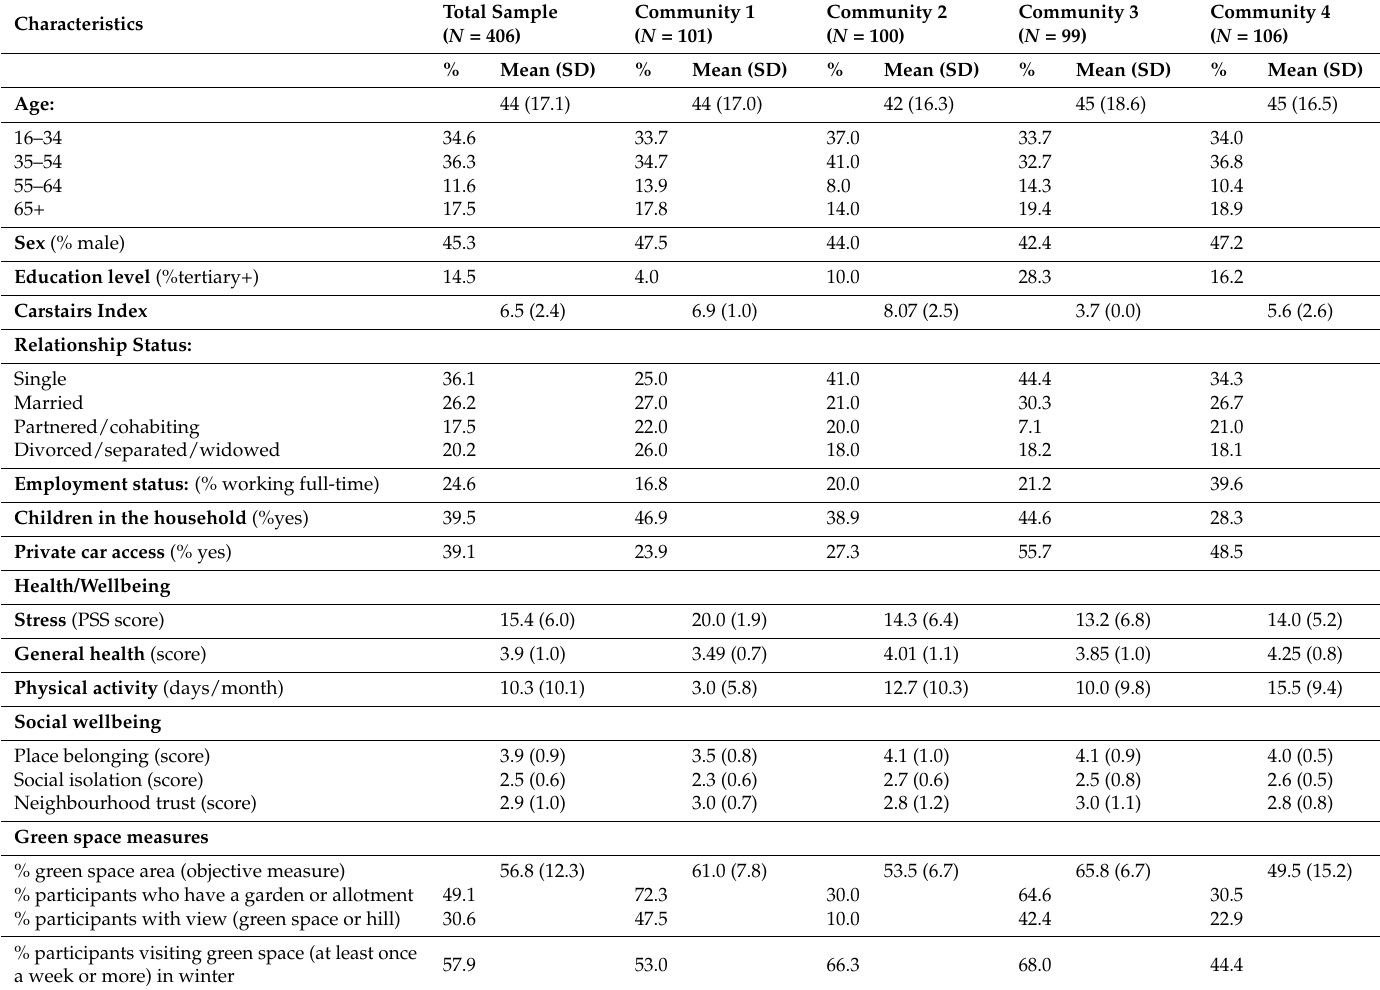
Table 1. C haracteristics of the sample ( N =